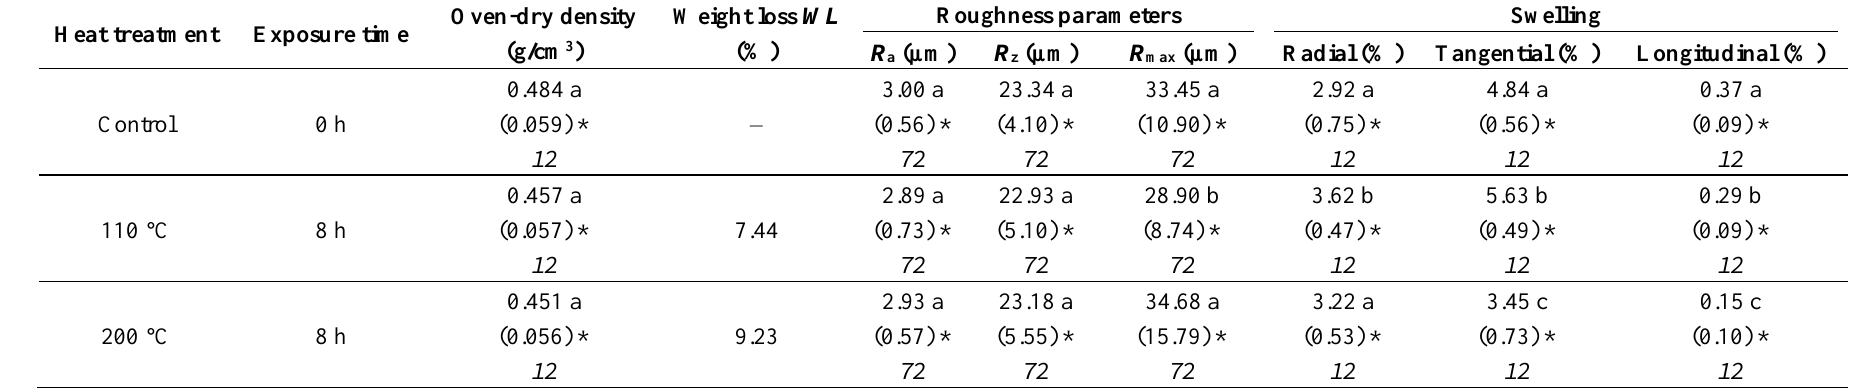
Table 2. Test results of heat-treated southern pine